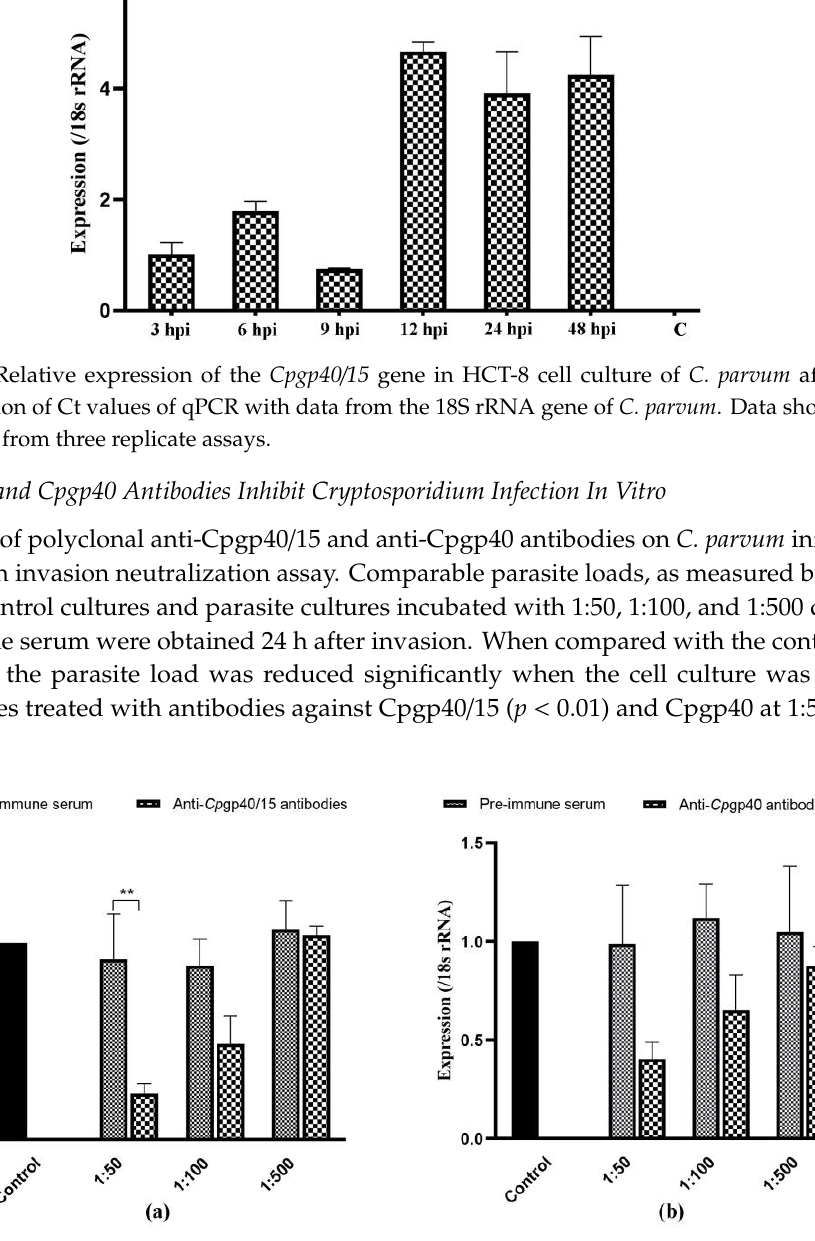
Figure 5. Inhibition of Cryptosporidium parvum invasion of HCT-8 cells by polyclonal Cpgp40 / 15 and Cpgp40 antibodies. ( a , b ) Control, C. parvum culture maintained in growth medium alone. 1:50, C. parvum culture with the addition of pre-immune or immune antibodies diluted 1:50. 1:100, C. parvum culture with the addition of pre-immune or immune antibodies diluted 1:100; 1:500, C. parvum culture with the addition of pre-immune or immune antibodies diluted 1:500; data shown are mean ± SD from three replicate